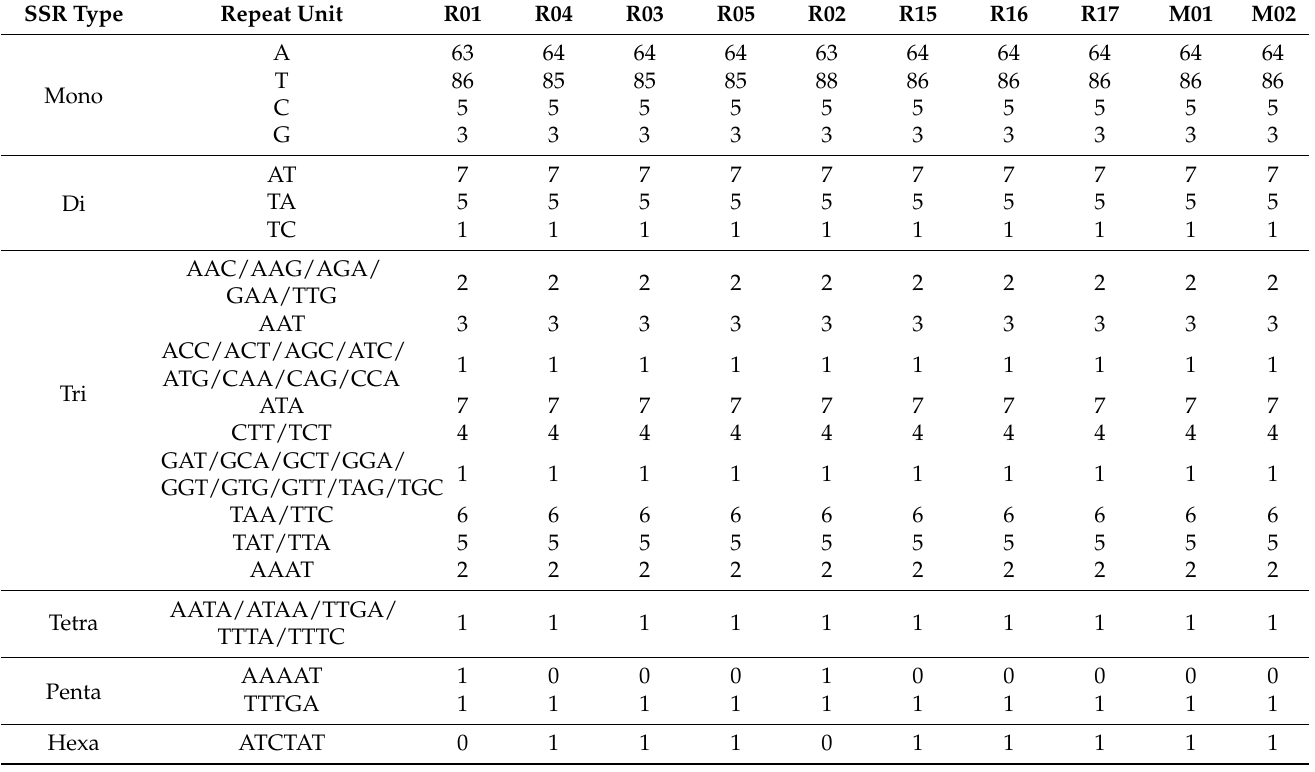
Table 2. Types and number of SSRs in the chloroplast genomes of Prunus mume